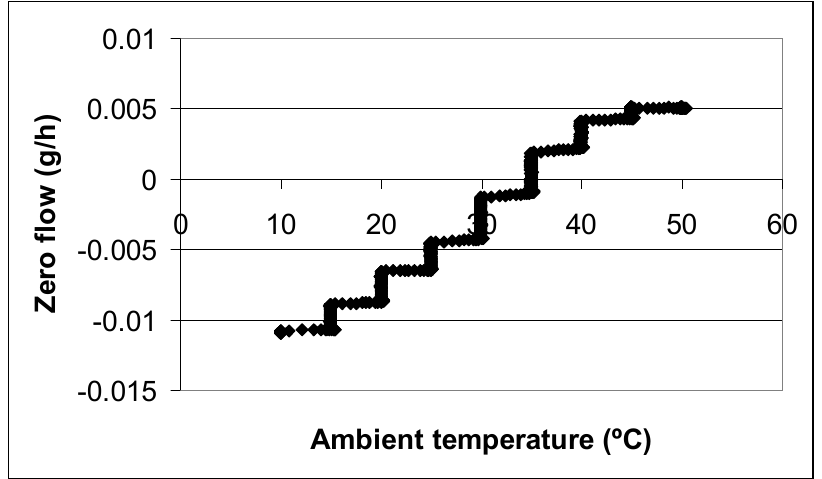
Figure 7. Measured temperature coefficient of the Coriolis mass flow meter. The meter was placed inside a climate chamber (Vötsch VC4018). The temperature was swept between 10 and 50 °C in steps of 5 °C every 2